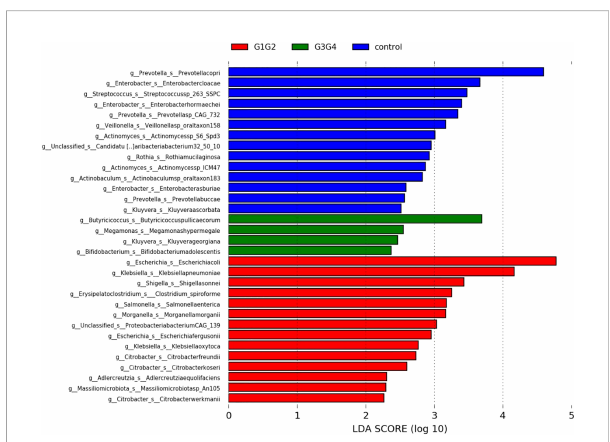
FIGURE 4 Signi fi cant differences in relative abundance identi fi ed by LEfSe analysis between the three groups (Control, G1G2 and G3G4). At the species level, the untreated group(control) is shown in blue, the intensive treatment group(G1G2) in red and the consolidation treatment group(G3G4) in green. The length of the column represents the in fl uence of signi fi cantly different species in relative abundance (LDA scores > 2).